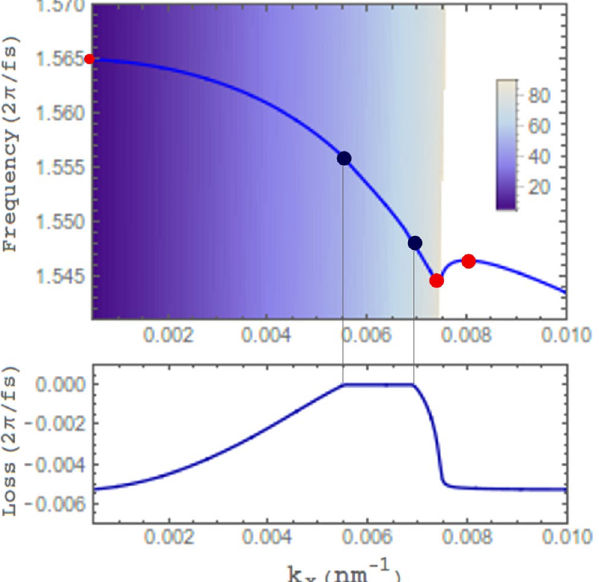
Figure 3. Dispersion curve of the FB mode with the shaded area corresponding to angles in the light cone (legend) and contains the part of the curve shown in the reflectivity profile of Fig. 1. Black dots (blue online) mark PAR points at k x = 5.52 × 10 − 3 nm − 1 and k x = 6.9 × 10 − 3 nm − 1 . The three gray dots (red online) represent ZGV points. One lying at k x = 0 at 1.565 rad/fs. The loss in the lower part of the diagram corresponds to the imaginary part of the complex